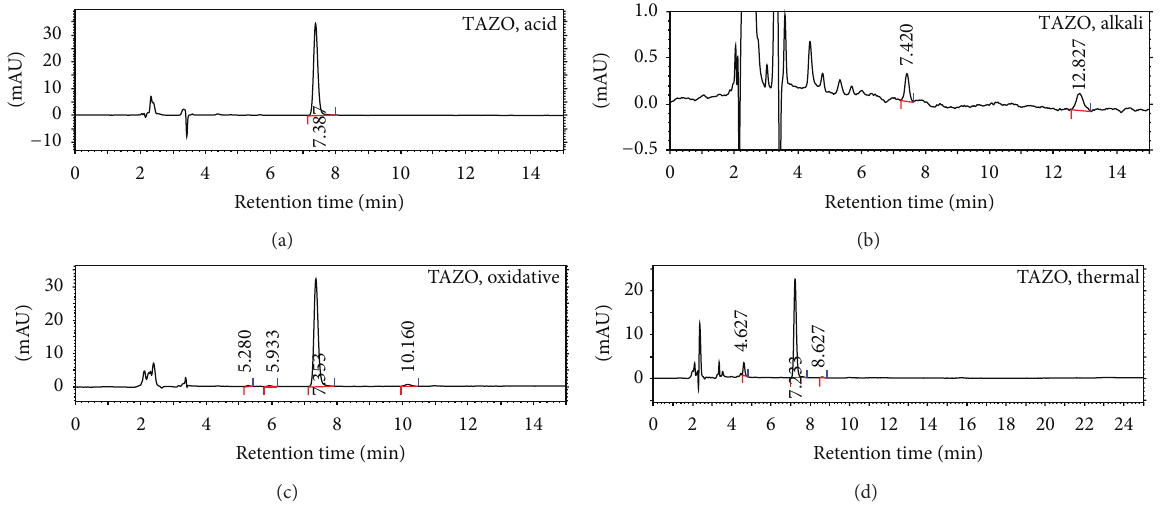
The method was found to be linear over the wide range and to be useful for bulk and pharmaceutical